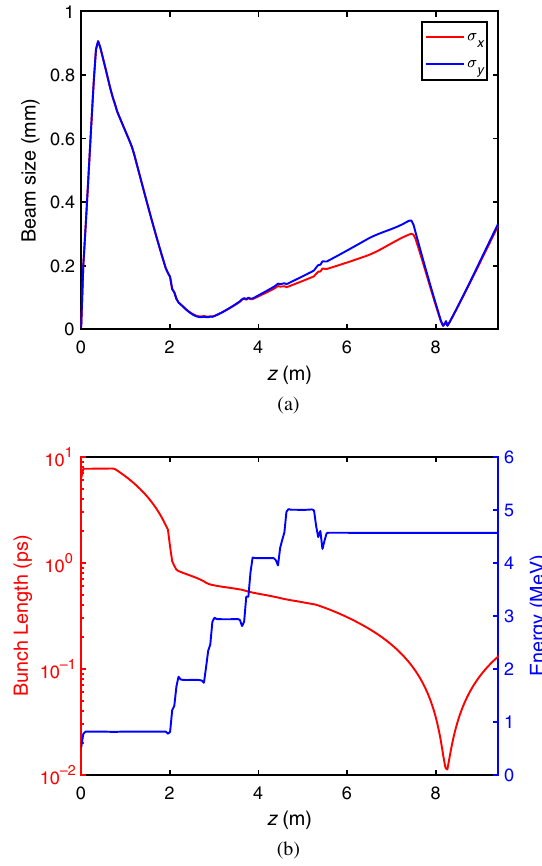
FIG. 7. (a) Beam width and (b) bunch length and energy throughout the injector at a final charge of 10 5 electrons = pulse. After the sample (and clipping) aperture at z ¼ 8 . 228 m, the bunch had an emittance of 2.6 nm, beam width of 5 μ m, and bunch length of 10